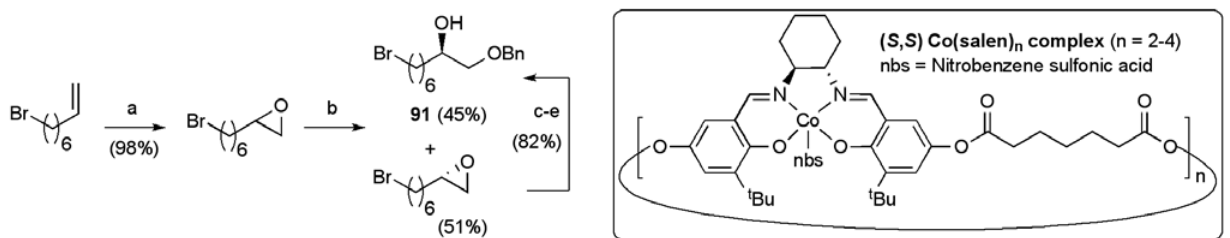
Scheme 22. Synthesis of benzyl ether 91